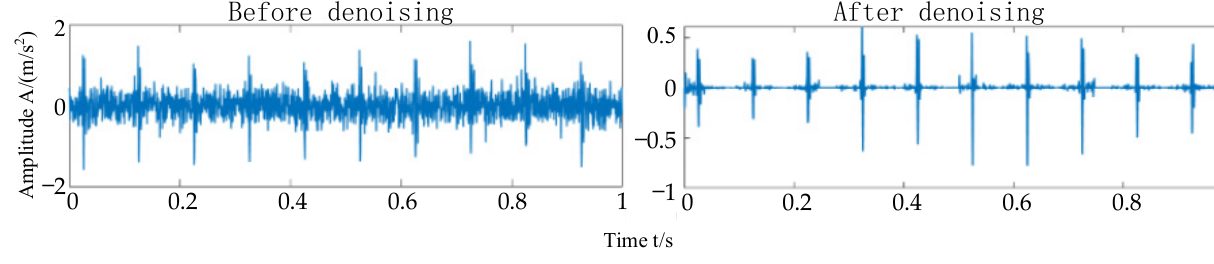
Figure 10. IMF1 denoising result.